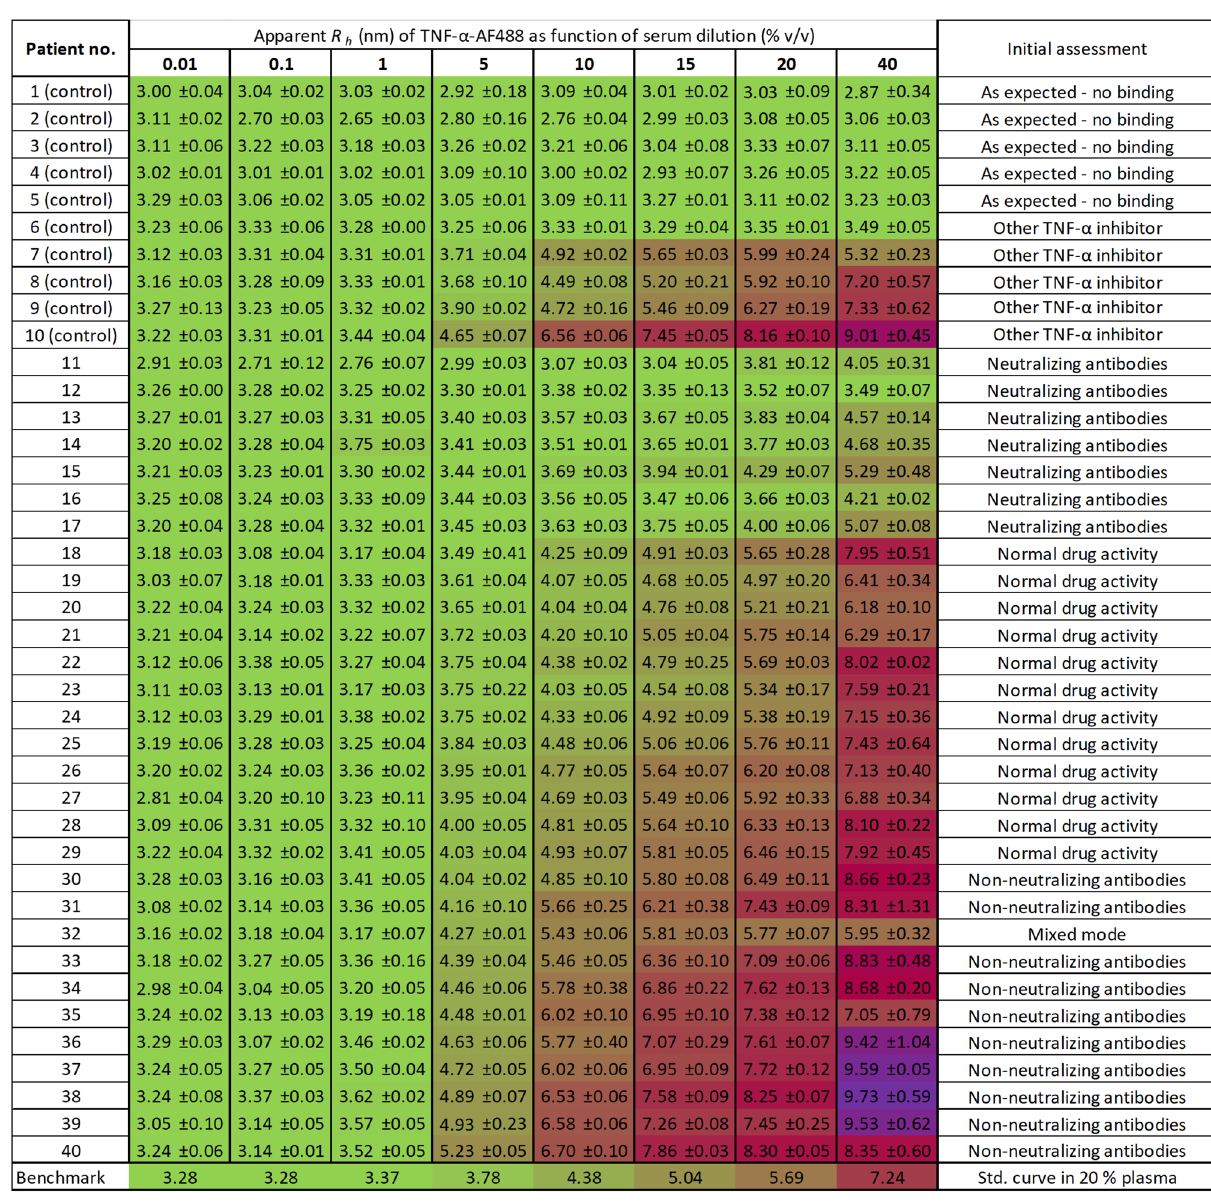
Figure 2. Overview and heatmap of 40 patient samples, showing the apparent hydrodynamic radius of TNF- α-AF488 (100 nM) as function of serum concentration (0–40% v/v) diluted with assay buffer, determined by FIDA at 25 °C (n = 3) with pre-incubated samples (> 10 min). Patients were renumbered and arranged according to response type. Last row depicts benchmark, based on values from a std. curve in 20% v/v